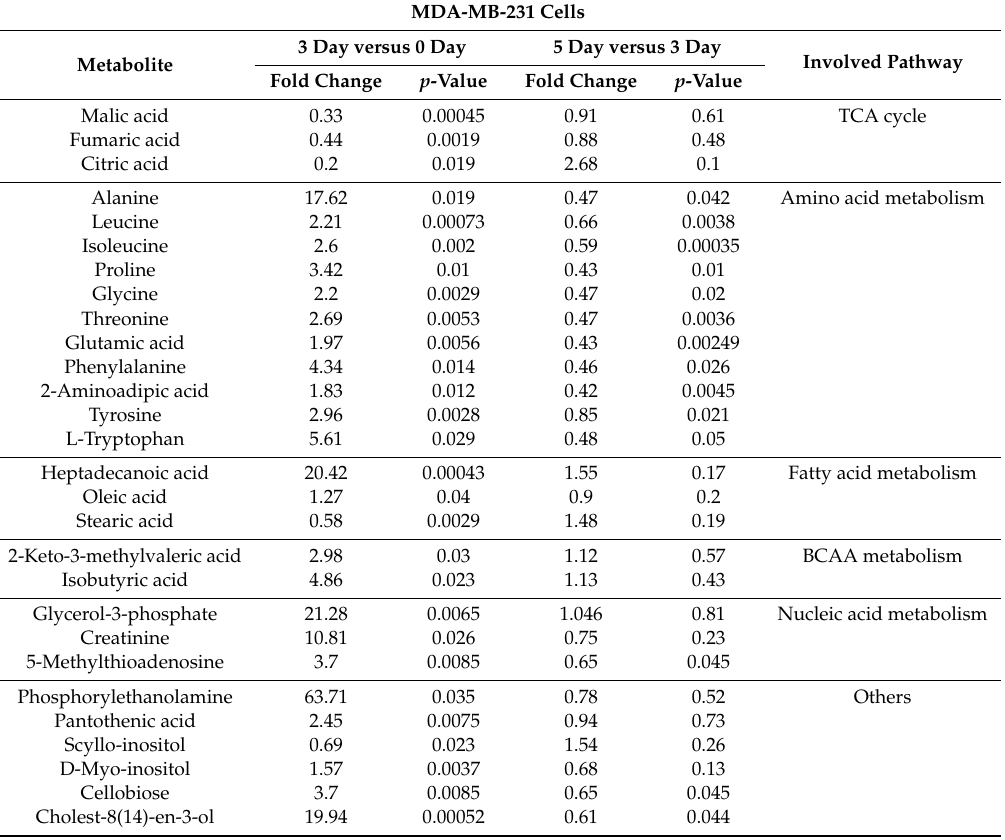
Table 2. Metabolites showing significantly altered levels during cell senescence in the MDA-MB-231 cell line and their related metabolic